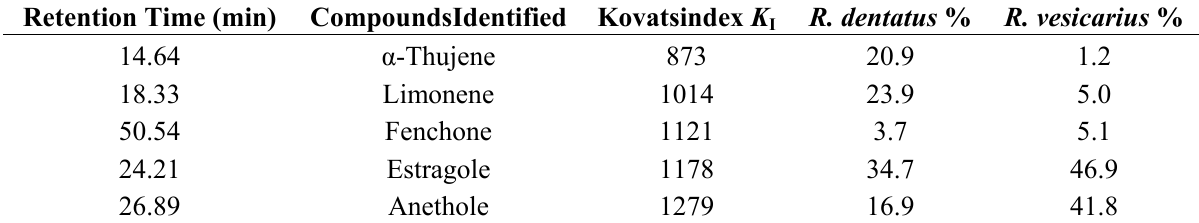
Table 1. Major monoterpenes identified and their percentage in the essential oil of Rumex dentatus and Rumex vesicarius .